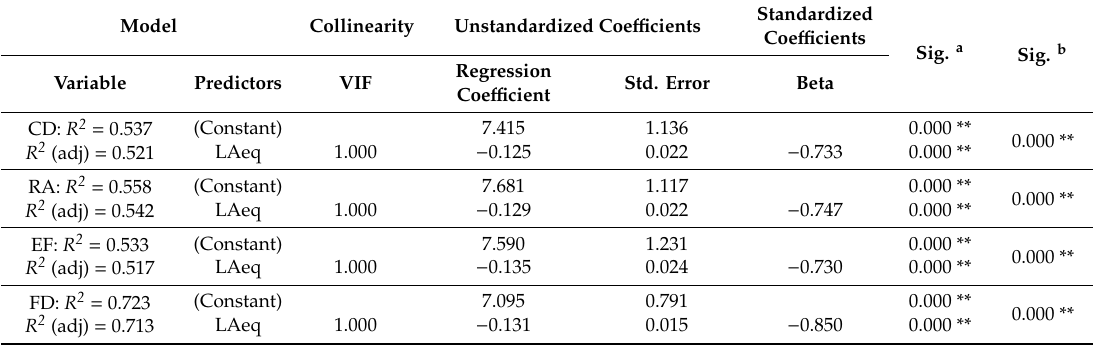
Table 2. Stepwise regression model for audio-visual contexts and psychological responses in Cloves